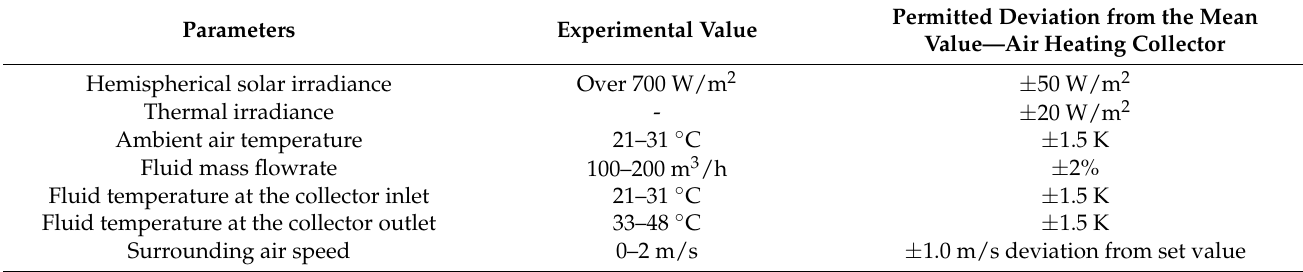
Table 3. Permitted deviation of measured parameters during a measurement period